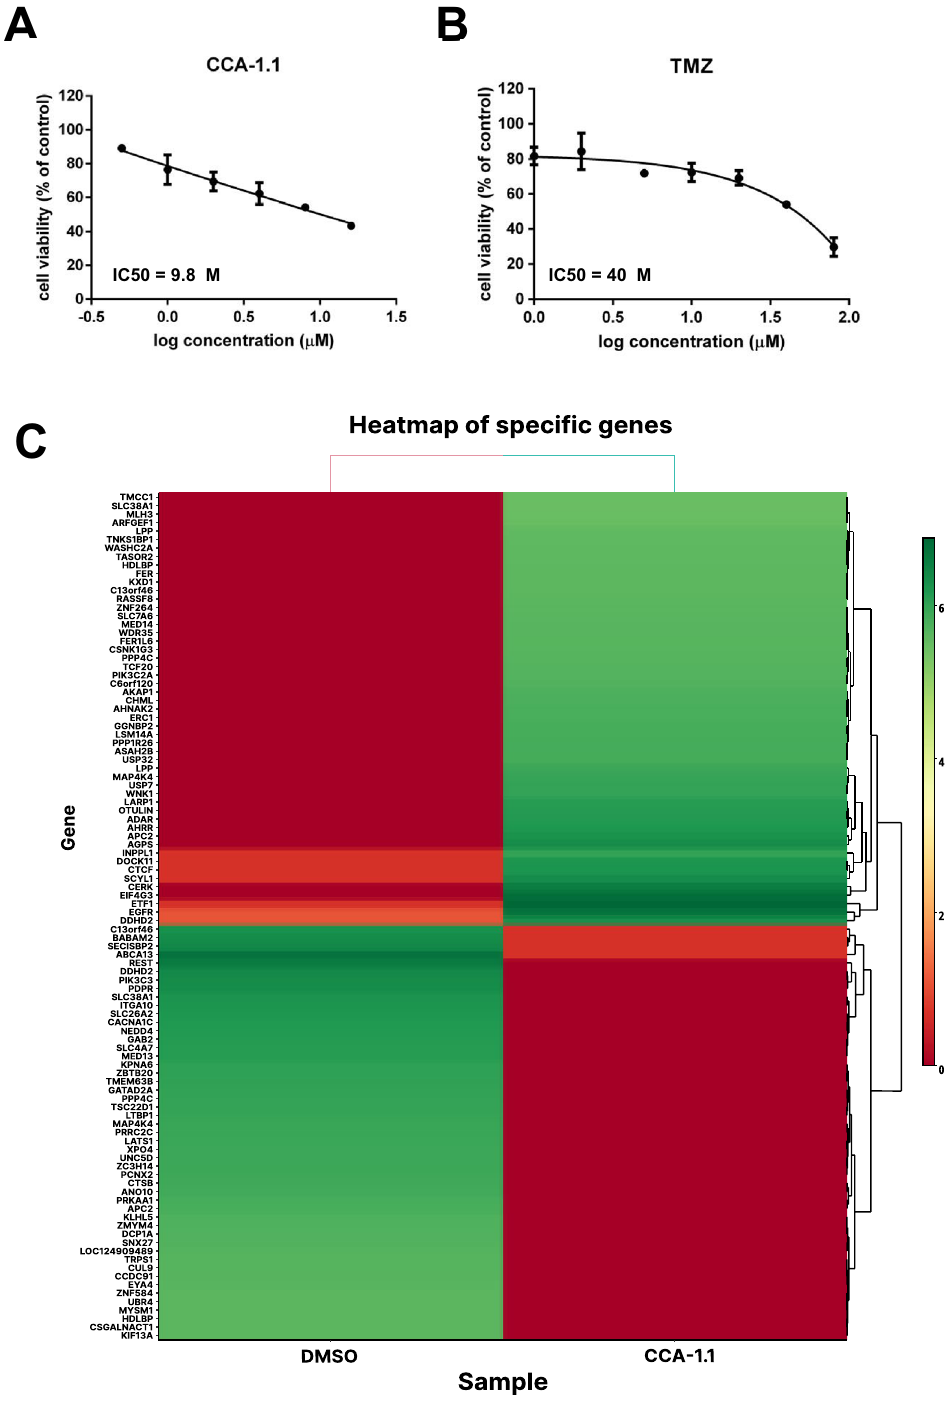
Figure 6. ( A ) Cytotoxicity of CCA-1.1 and ( B ) TMZ in U87 glioblastoma cells. Cytotoxicity was determined using an MTT assay and presented as cell viability as explained in the methods section. Results are shown as the average of the three independent experiments (mean ± SD). ( C ) Heat map of top 100 DEGs between the U87 cells treated with CCA-1.1 and the